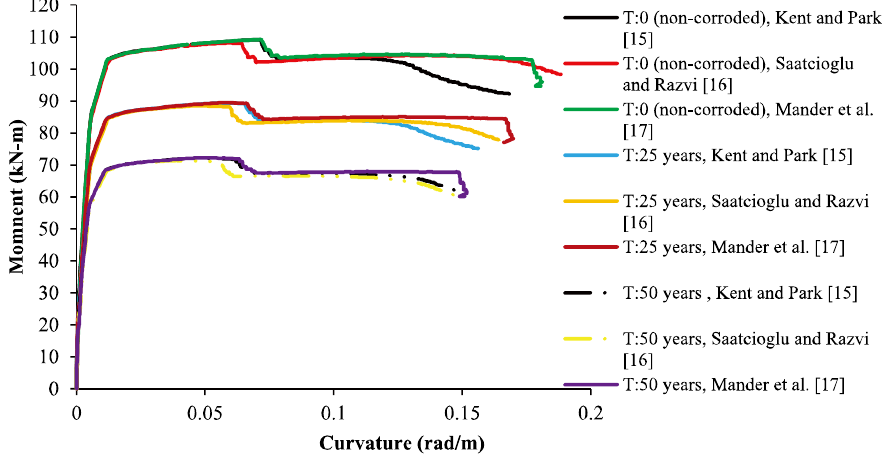
Fig. 5. Time-dependent moment-curvature relationships of S 1